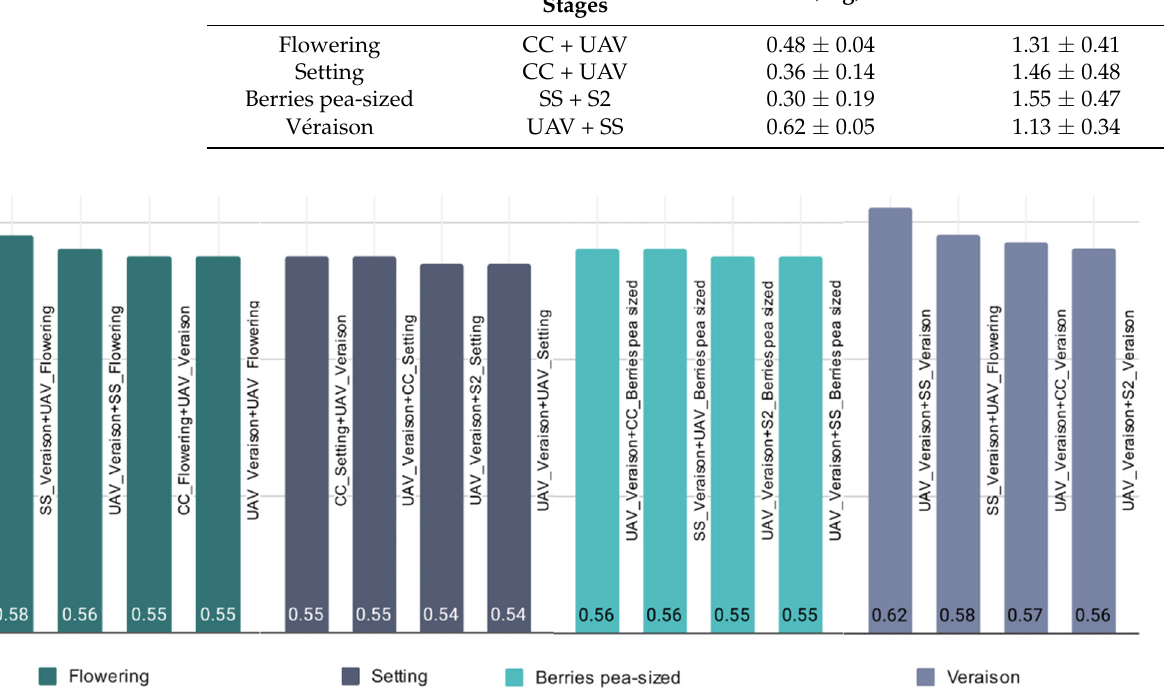
Figure 6. Given a growth stage (Flowering, Setting, Berries pea-sized, Véraison) selected best performed R 2 for the combination of sensors and growth stages over the two growing seasons (2019 and 2020), using AutoML to assess their performance in evaluating grape quality attributes (legend as for Table 2).